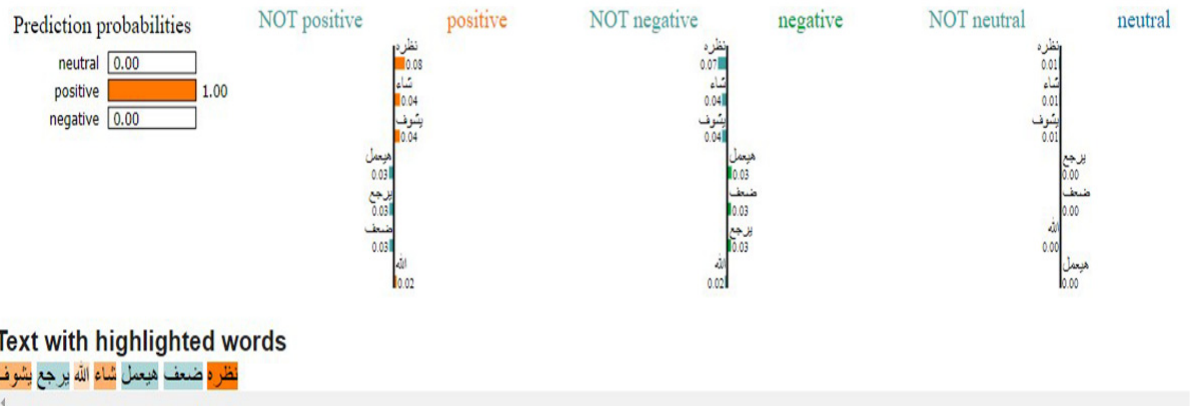
Figure 4. LIME results for LASIK surgery Positive sentiment.